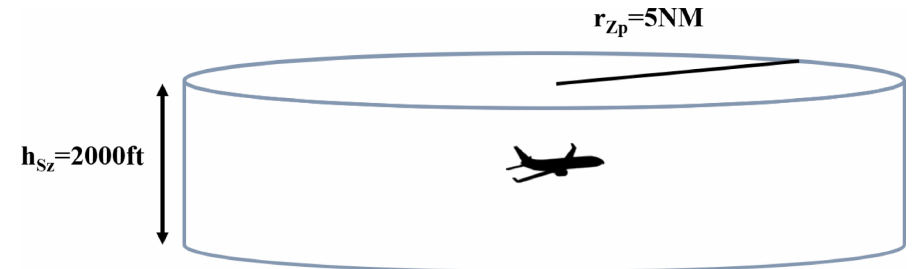
Figure 3. Separation zone of an aircraft. From Degas et al.